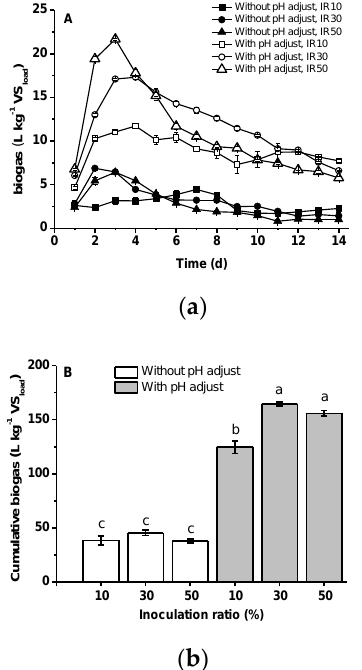
Figure 5. Effect of pH adjustment and different IR on daily biogas yield ( a ) and cumulative biogas yield ( b ). Data indicate mean and its standard deviation of triplicates. Bars without the same lowercase letter(s) differ significantly ( p < 0.05).